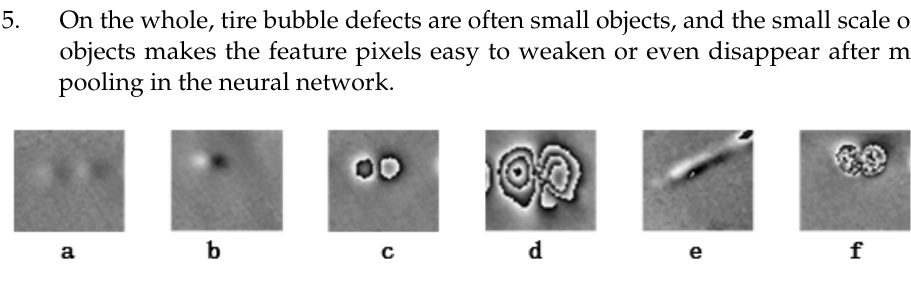
Figure 1. Tire Speckle Interference Bubbles. ( a – f ) are the bubble part of the tire laser speckle interference bubble defect image, the pixel size of these images is 67 × 67, and the size of the bubble defect is lower than 32 × 32, which belongs to the size range of small